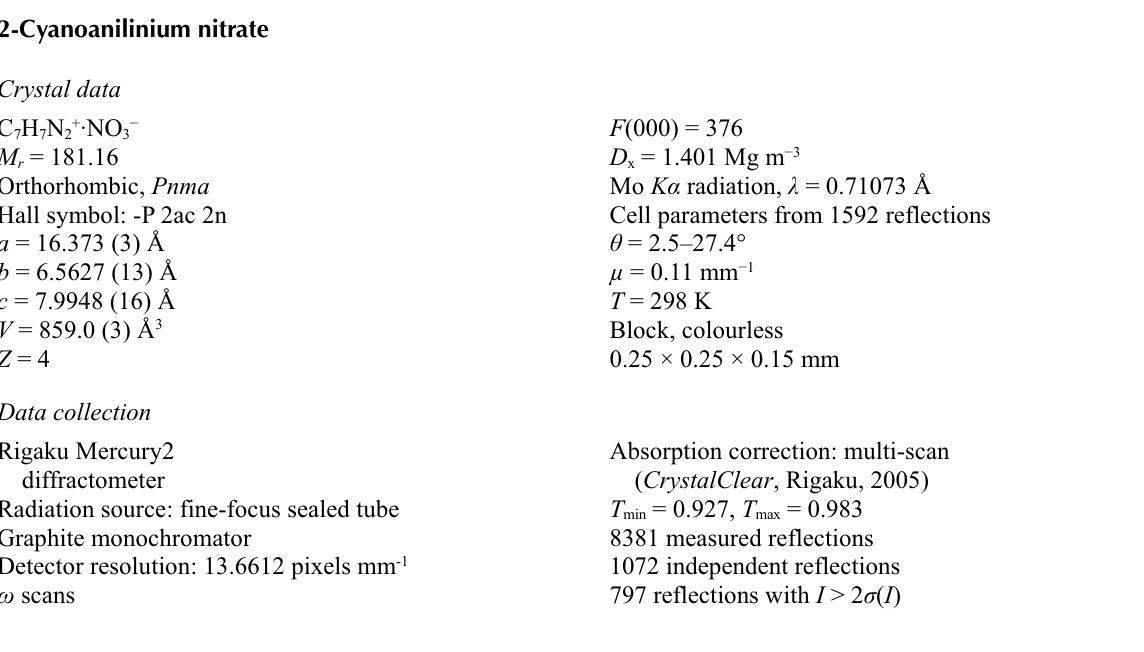
Part of the crystal packing of the title compound viewed along the c axis. H atoms not involved in hydrogen bonding (dashed lines) have been omitted for